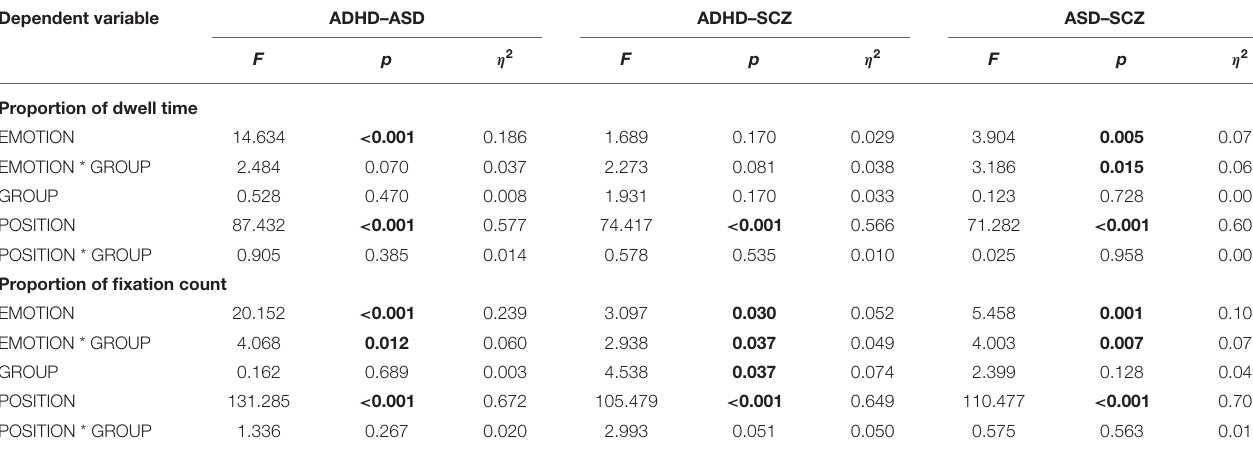
TABLE 2 | Pairwise mixed ANOVA’s between the clinical